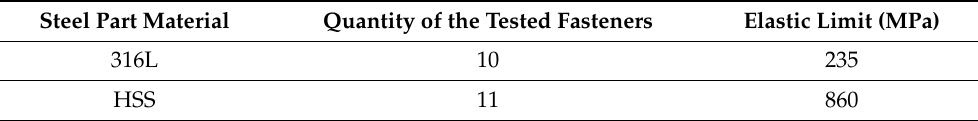
Table 1. Elastic limits of steel types (fasteners).